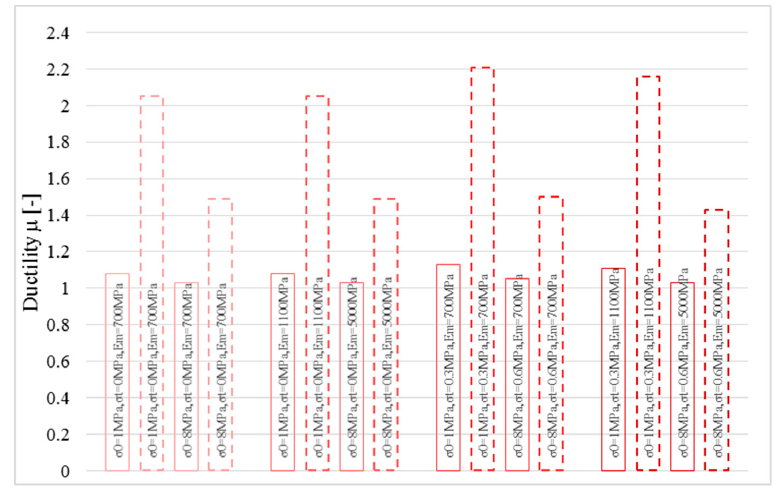
Figure 11 . Ductility estimation for the two stress-strain relationships for basalt fiber: P = 0 N, for linear (solid lines) and bi-linear (dotted lines).